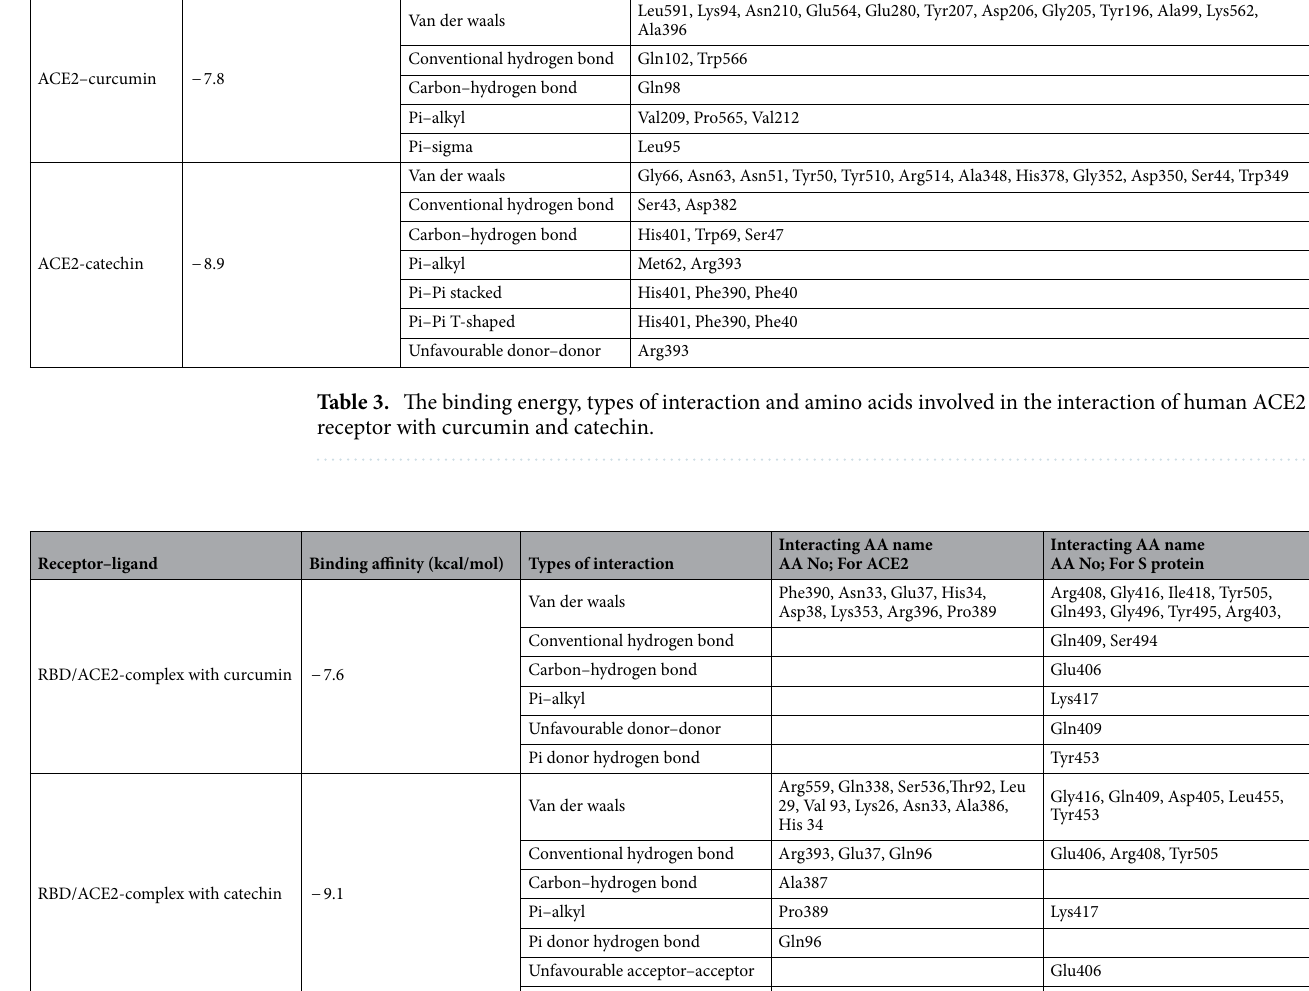
Table 4. The binding energy, types of interaction and amino acids involved in the interaction of RBD/ACE2- complex with curcumin and catechin.